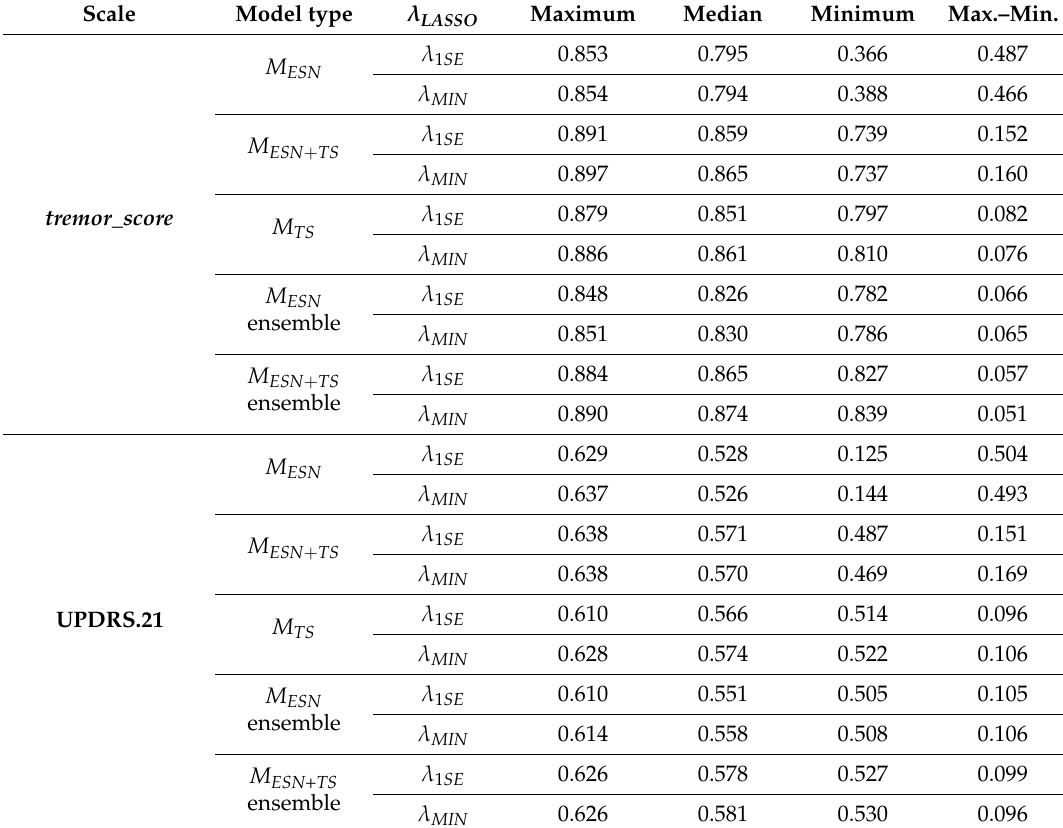
Figure 7. Prediction quality of different types of models, as achieved with the test set. The median correlation for each model type is marked by a dot, the whiskers extend between the minimum and maximum values of correlation. Table 4. Summary of Pearson’s correlations of model predictions and target values.